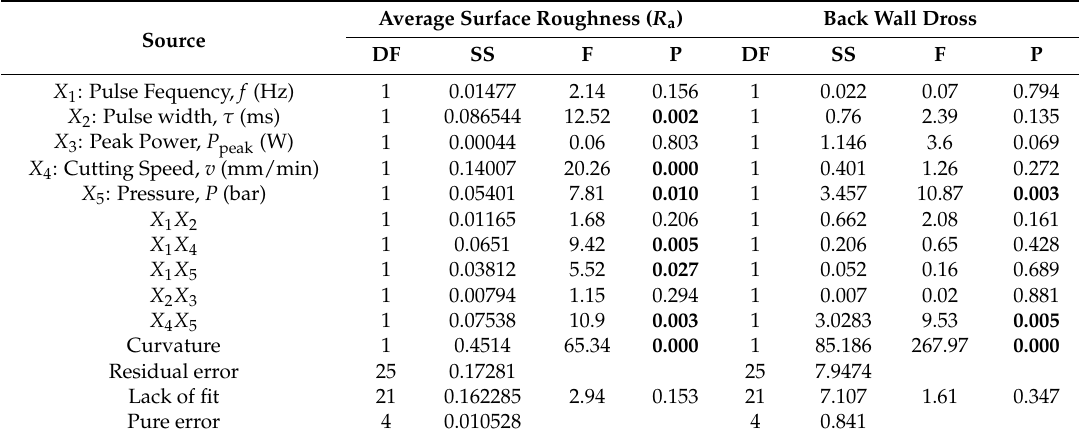
* Miniature tube B: Hard drawn 1.8 mm OD and 160 μ m wall thickness ( p -values below 0.05 are bolded).